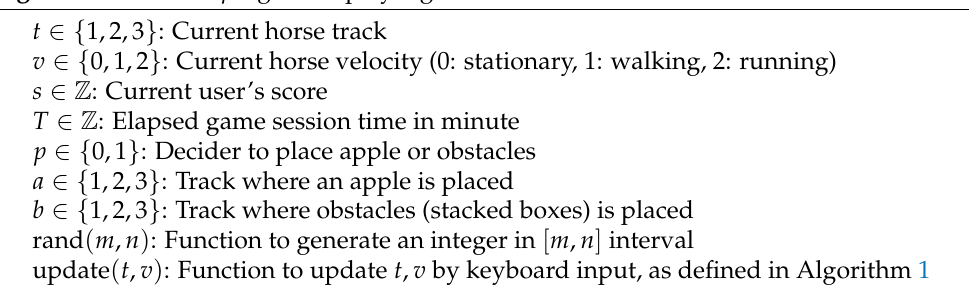
Algorithm 2 Sirkus Apel general play